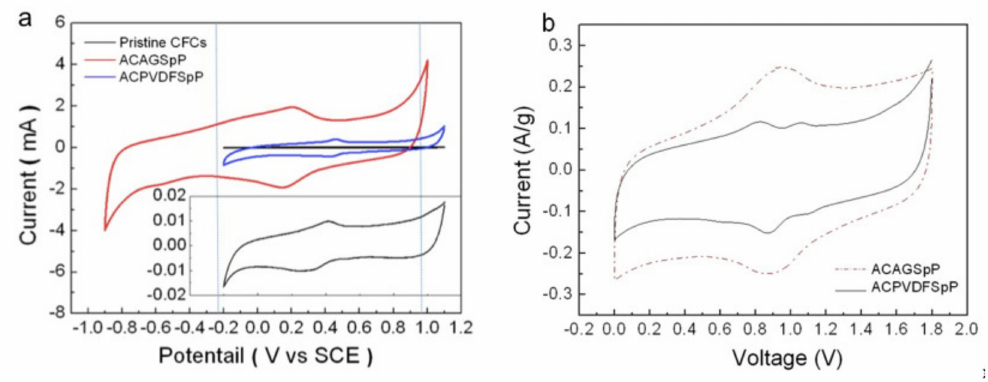
Figure 2. (color online) ( a ) CV curves show potential windows of ACAGSpP electrodes (red), ACPVDFSpP electrodes (blue), and pristine CFCs (black) in H 2 SO 4 (1 M) at a scan rate of 10 mV/s; inset displays an enlarged plot of pristine CFCs; ( b ) CV curves obtained for symmetric aqueous SCs employing ACAGSpP electrodes or ACPVDFSpP electrodes at 10 mV/s with maximum voltage of 1.8